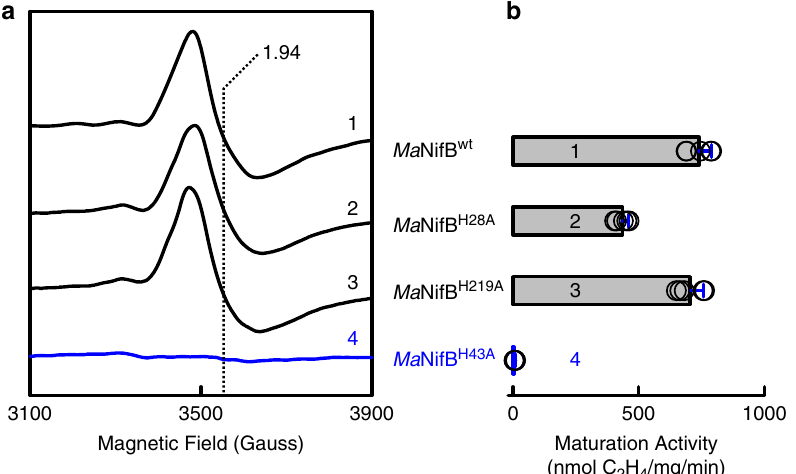
Fig. 2 Conversion of L-cluster to M-cluster on Ma NifB proteins. a EPR spectra of IDS-oxidized Ma NifB wt (1), Ma NifB H28A (2), Ma NifB H219A (3), and Ma NifB H43A (4) upon addition of SAM. Formation of the L-cluster was monitored by the appearance of an L-cluster-speci fi c S = 1/2 signal at g = 1.94 (dashed vertical line). All protein samples have a concentration of 15 mg mL − 1 . The EPR spectra were recorded at 5 mW and 20 K. b M-cluster maturation activity of Ma NifB wt (1), Ma NifB H28A (2), Ma NifB H219A (3), and Ma NifB H43A (4). The activity of M-cluster maturation was determined on the basis of the C 2 H 2 -reducing activity of reconstituted NifDK, using SAM-treated Ma NifB proteins as the M-cluster sources. The EPR analysis was performed three times independently ( n = 3 independent samples), and representative results are shown in ( a ). The maturation assay was performed fi ve times independently ( n = 5 independent samples), and data are presented as mean ± S.D. ( b ). See Methods for the detailed composition of maturation